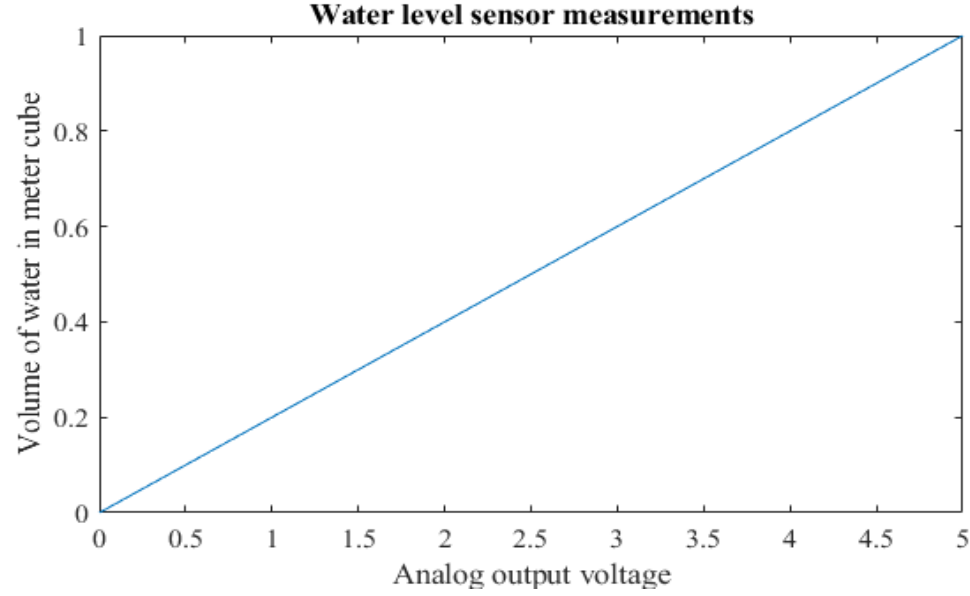
Figure 14. Results of water volume measured in meter cube against the generated output voltage. A rectangular tank of height ‘h’ and width ‘w’ of 1 m was considered to calculate the threshold level or depth ‘d’ for water level sensor. The water volume V in the tank can be calculated using the relation V = h × l × d under step size 1/1024 = 0.00097. This indicates that every one degree change in ADC corresponds to one degree change in depth. Thus, the height and width are constant if an ADC reads the 512 value than V = 0.4964 m 3